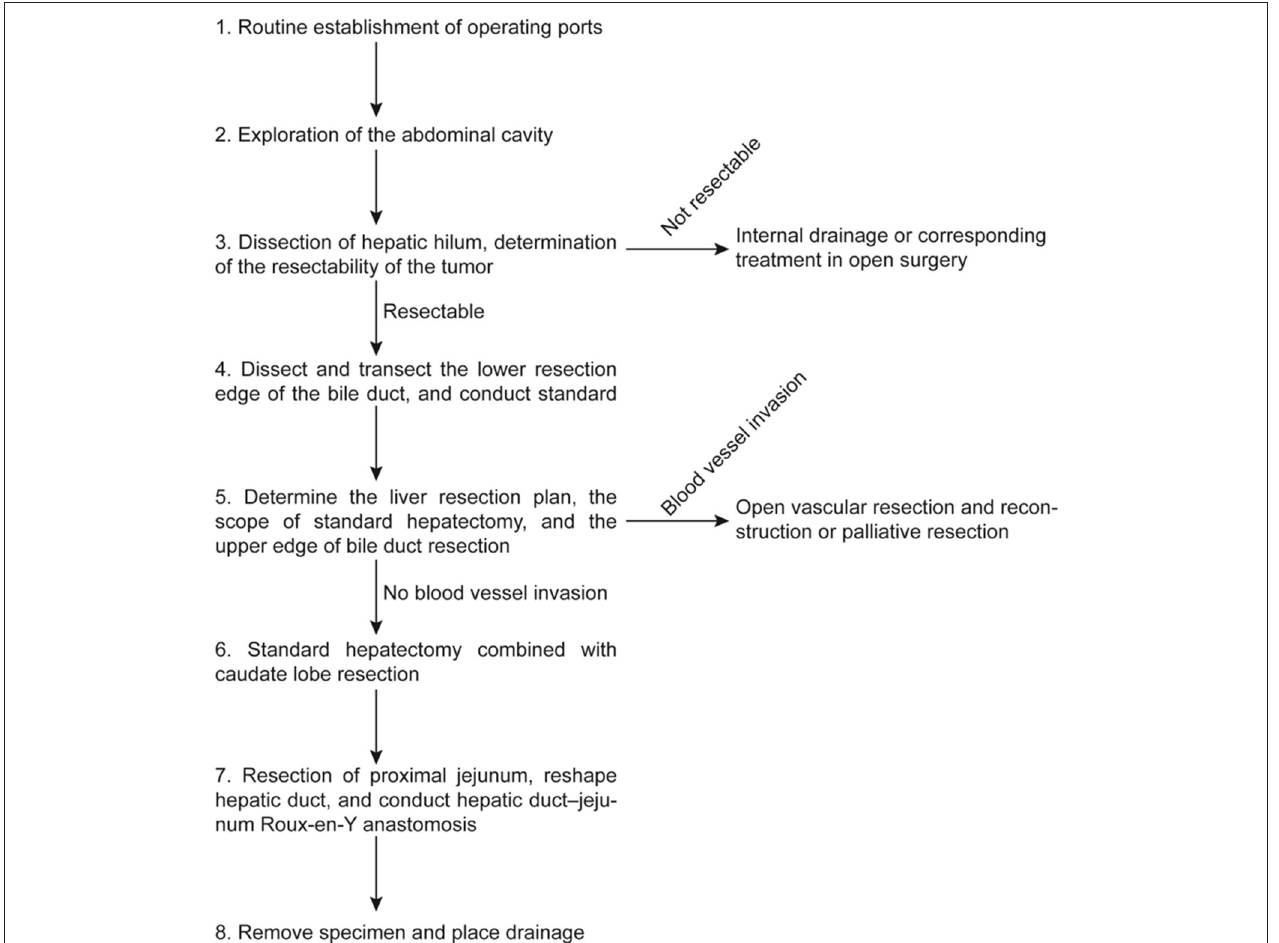
FIGURE 2 | Operation flowchart. This operation procedure was based on the recommendations of the experts who participated in the consensus meeting to provide a clinical reference for less experienced surgeons. Surgeons should carry out his/her operation procedures according to the specific situations during operation.